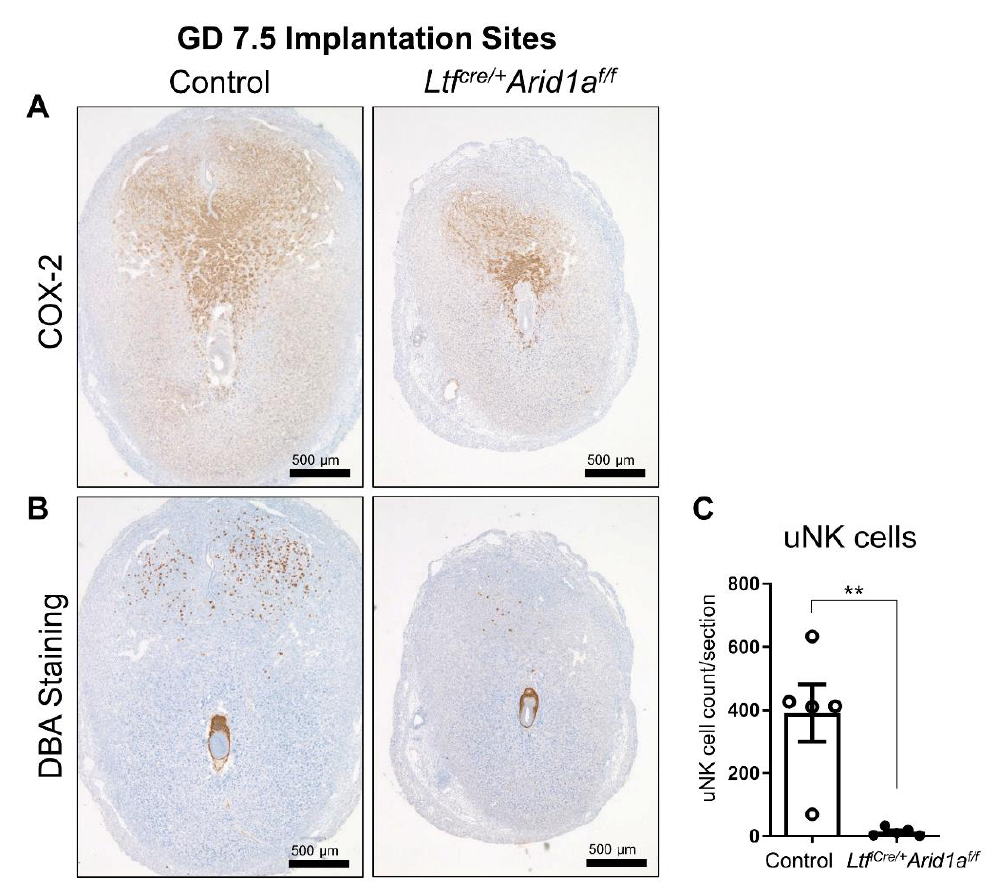
Figure 2. Deletion of endometrial epithelial Arid1a in mice causes diminished decidual area and decreased uNK cell numbers in GD 7.5 implantation sites. ( A ) Representative images of COX-2 IHC in control and Ltf iCre/+ Arid1a f/f mouse uteri at GD 7.5 ( n = 5 IS/genotype). ( B ) Representative images of DBA lectin staining for uNK cells in control and Ltf iCre/+ Arid1a f/f mouse uteri at GD 7.5 ( n = 5 IS/genotype). ( C ) Quantification of the average number of DBA-stained uNK cells counted per tissue section in control ( n = 5 IS, empty bar) and Ltf iCre/+ Arid1a f/f ( n = 5 IS, grey bar) uteri. The graph represents the mean ± SEM. **, p < 0.01. Abbreviations: Arid1a , AT-rich interaction domain 1A; COX-2, cyclooxygenase-2; DBA, Dolichos biflorus ; GD, gestation day; IS, implantation site; Ltf , lactoferrin; uNK, uterine natural killer.